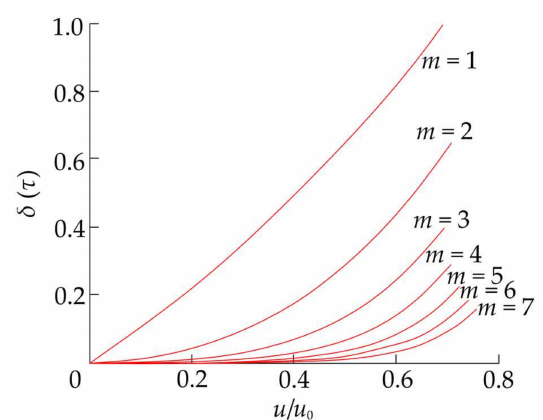
Figure 4. Series of error curves for different values of m .